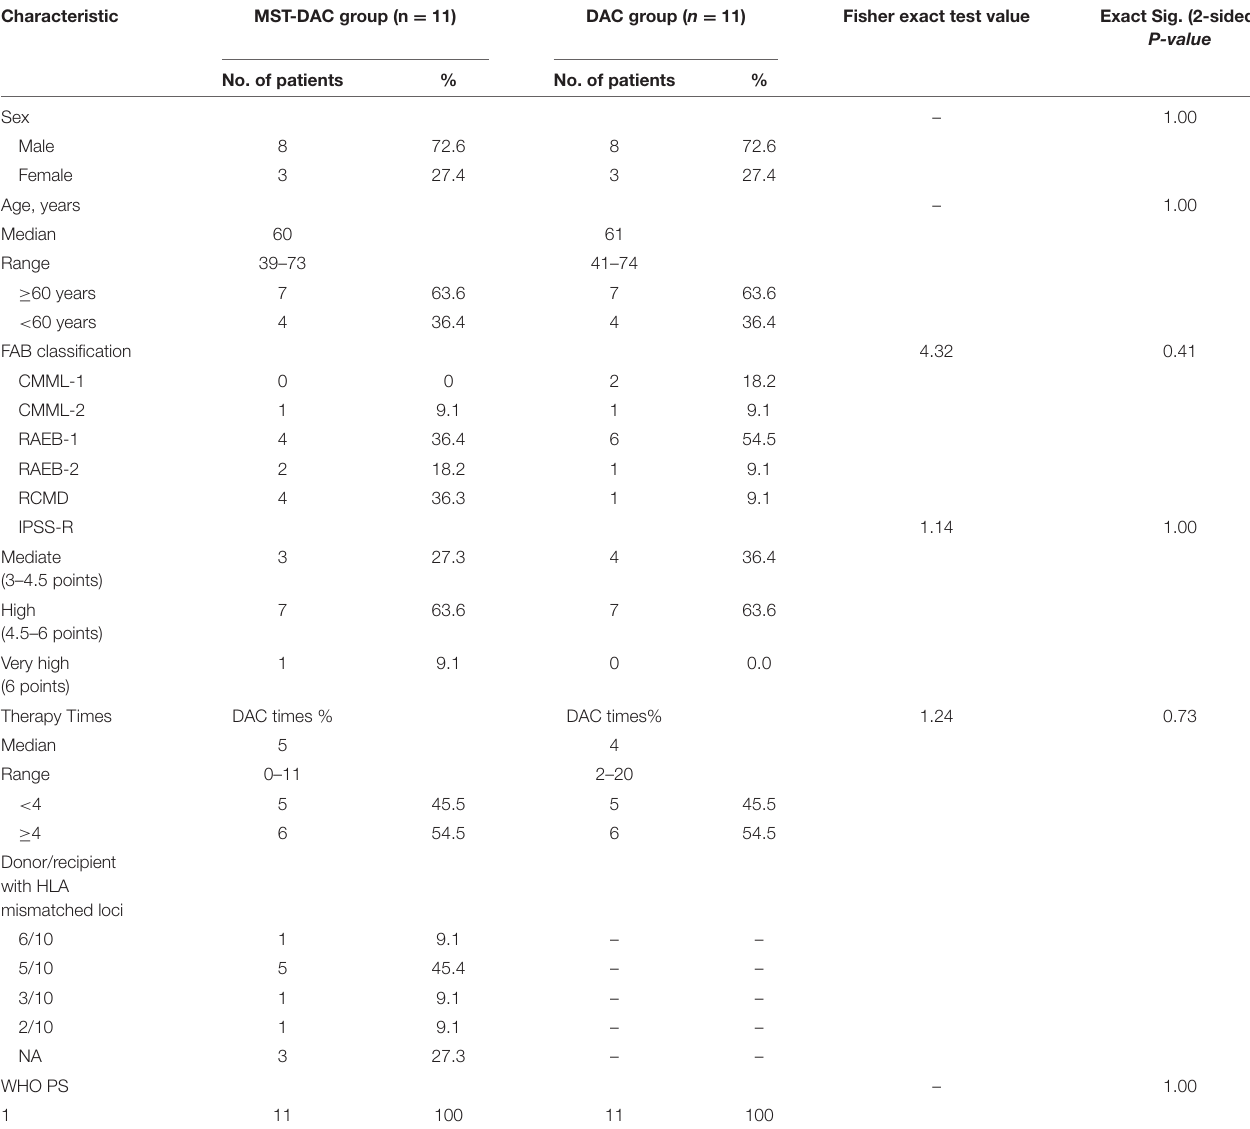
TABLE 1 | Patient demographics and clinical characteristics.